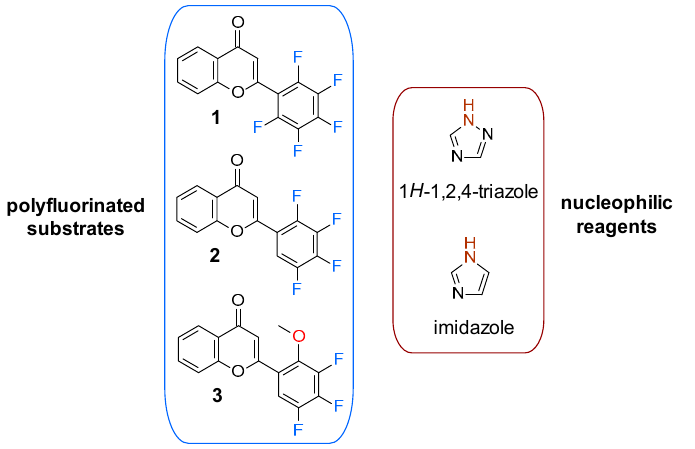
Figure 1. Polyfluorinated flavones in the S N Ar reaction with the 1 H -1,2,4-triazole and imidazole under study in this work.